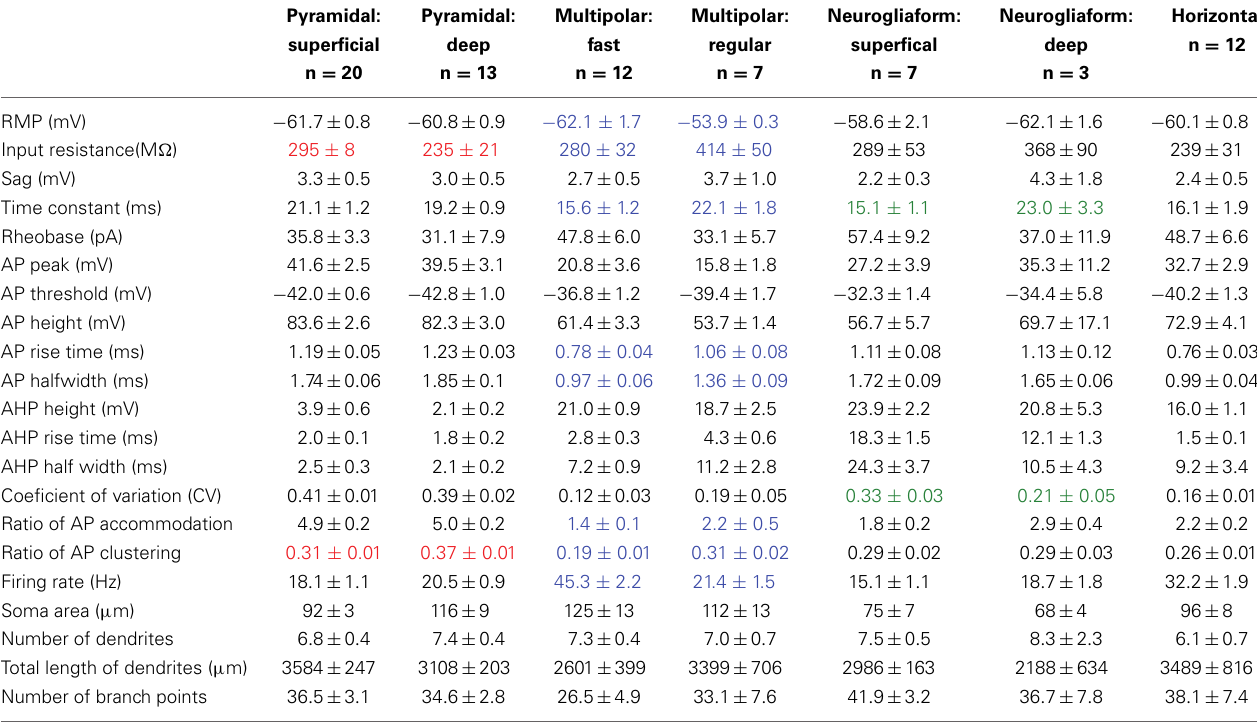
Table 2 | Electrophysiological and morphological properties of seven cell classes. Pyramidal: Pyramidal: Multipolar: